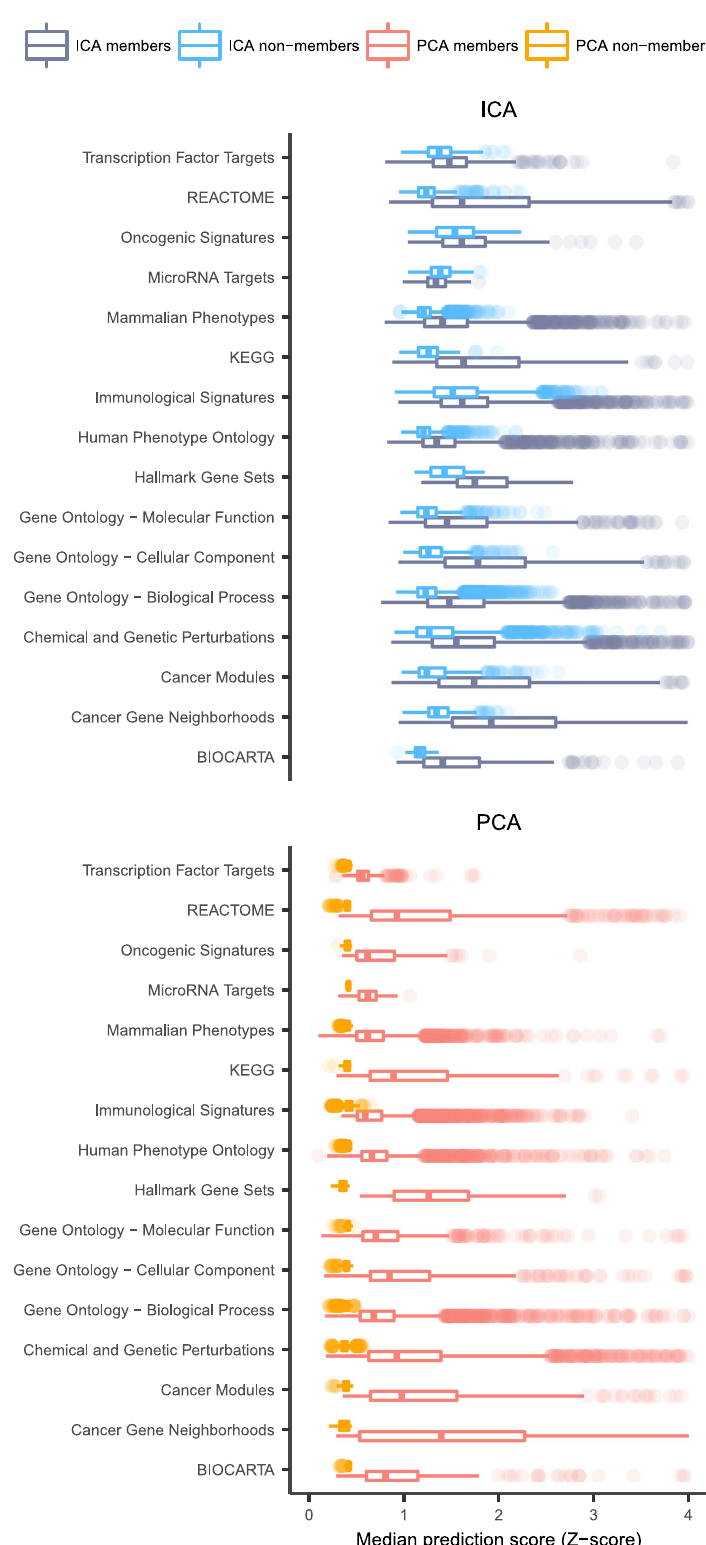
Fig. 2 Distribution of prediction scores for both the ICA-TC- and PCA-TC-based method. Boxplot of median prediction scores ( x -axis) calculated from the ICA-TC-based (blue) and PCA-TC-based (red) methodology for each of the 16 gene set collections ( y -axis). Median prediction scores are calculated separately for each gene set using both the ICA-TC- and the PCA-TC-based method for member (saturated) and nonmember genes (less saturated) and plotted side to side. Prediction scores of ICA-TC-based method are higher for both the members and the nonmember gene subset. ICA-TC-based predictions outperformed PCA-TC by obtaining higher median prediction scores for current member genes in all gene set collections (area under the curves (AUCs) calculated from two-sided Mann – Whitney U test range 0.7 – 0.99). Hinges of boxes represent second and third quartiles and whiskers extend by half that interquartile range. Center of box corresponds to